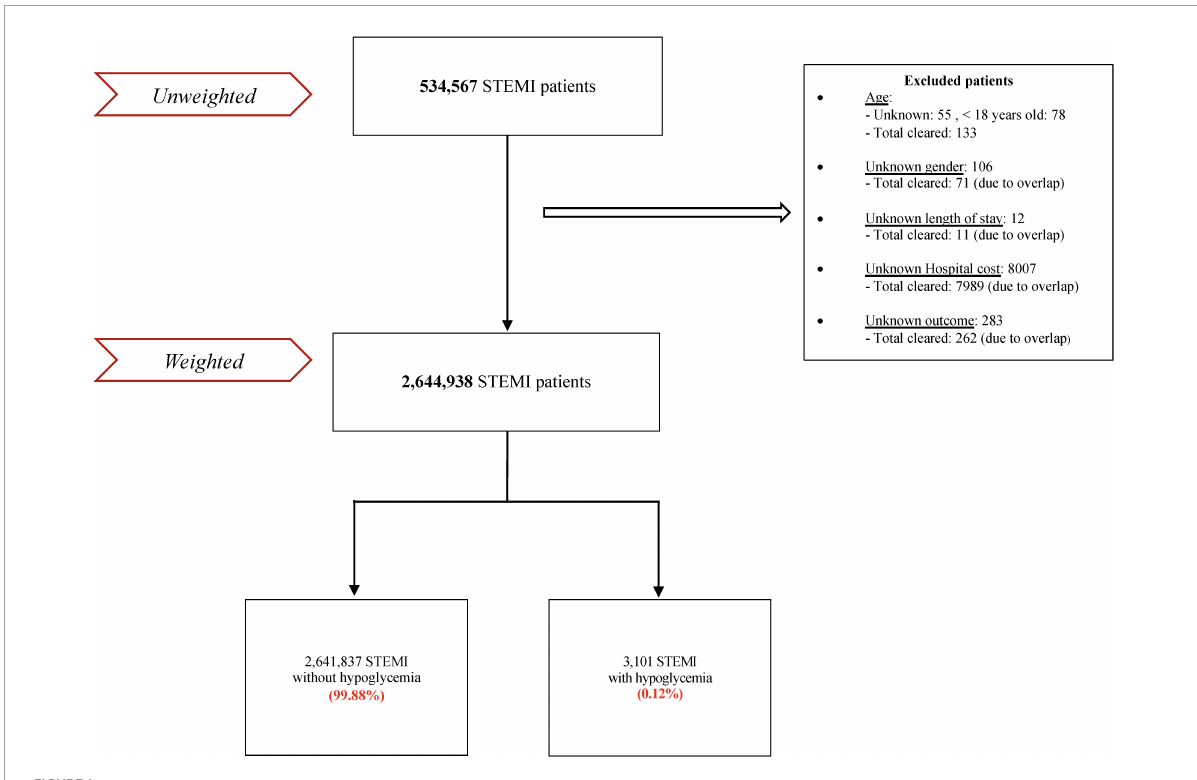
FIGURE1 Flowchart of the